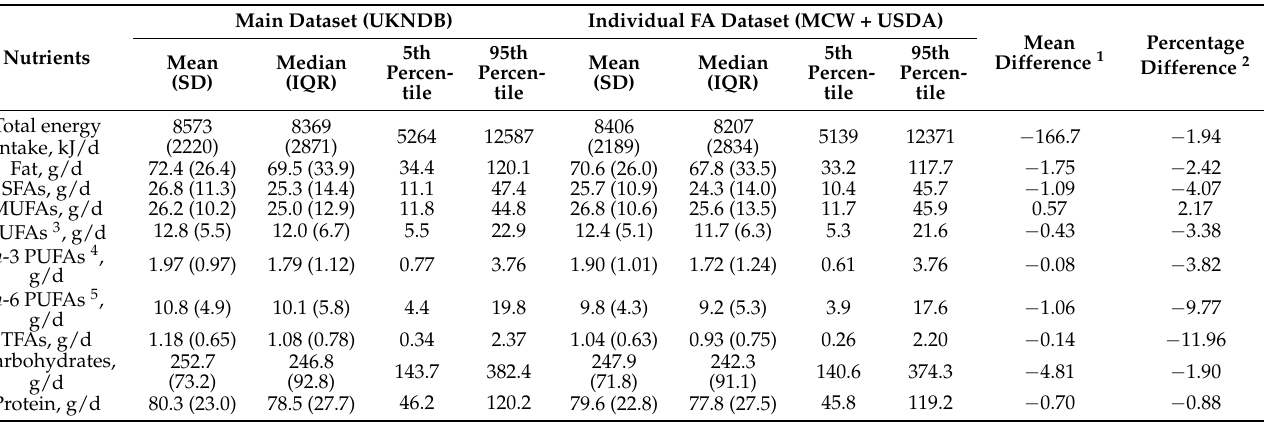
Table 2. Comparison of total energy and major nutrient intakes between the main dataset (UKNDB) and the individual FA dataset (MCW + USDA) in 207,997 UK Biobank participants.